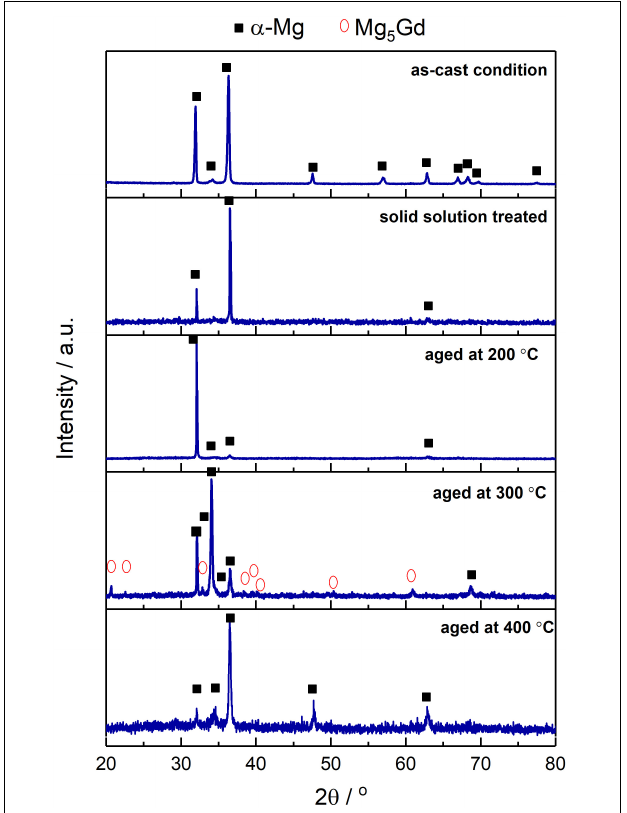
FIGURE 1 | X-ray diffraction patterns of as-cast, solution treated and heat treated at 200 ◦ C, 300 ◦ C, and 400 ◦ C conditions of Mg-10Gd alloy (Silva Campos,